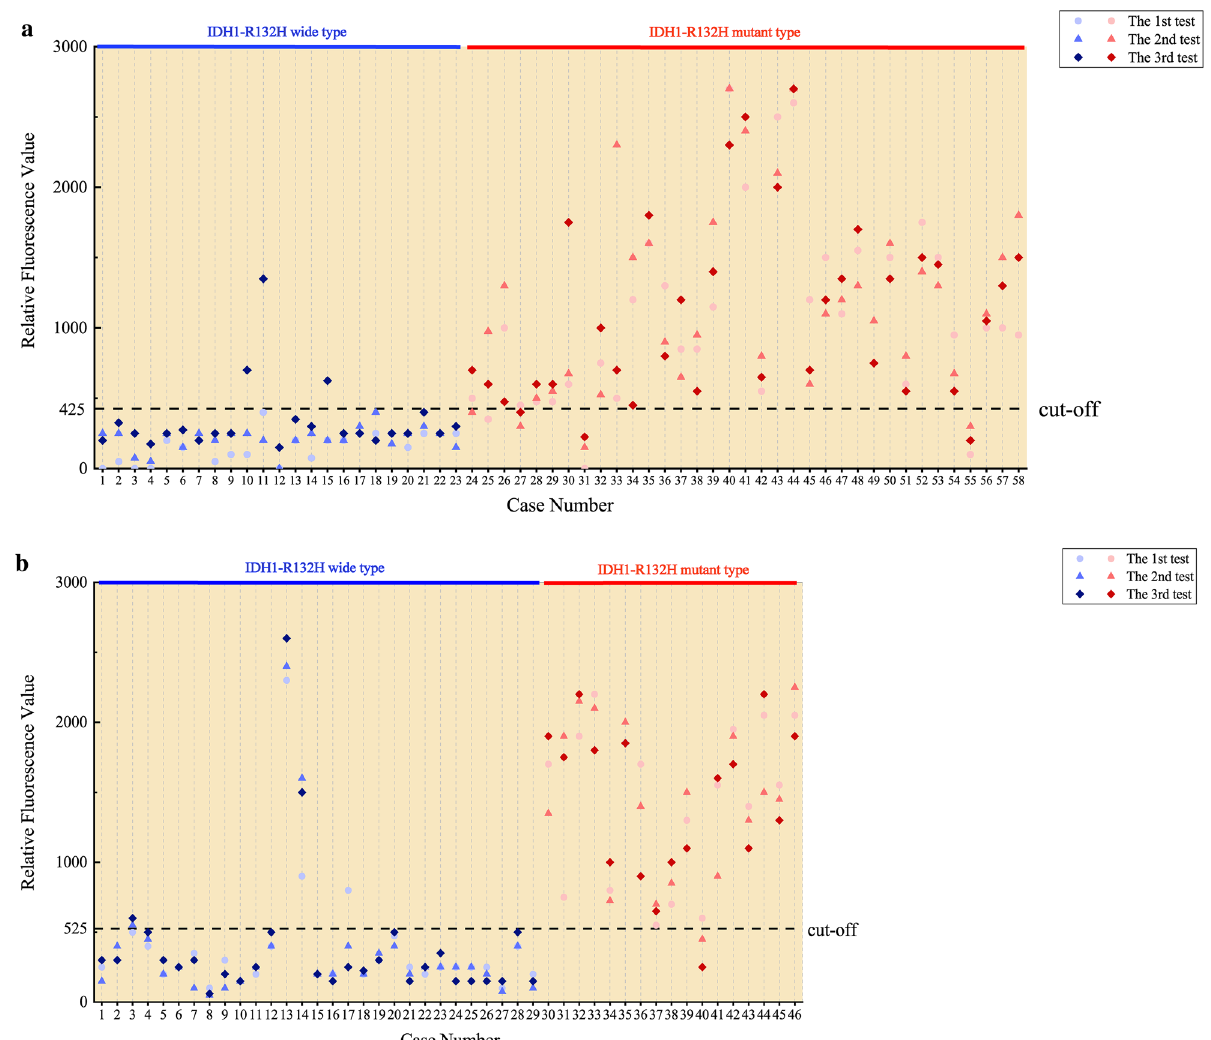
Figure 5. Scatter diagram of relative fluorescent value. ( a ) The relative fluorescent value of all samples in Group 1. No.10, No.11 and No.15 IDH1-wt samples had high relative fluorescent value, while No.8 and No.32 IDH1-R132H samples had low relative fluorescent value, which was not consistent with the gold standard. ( b ) The relative fluorescent value of all samples in Group 2. There was a significant difference between the relative fluorescent value of IDH1-wt and IDH1-R132H. No.13 and No.14 IDH1-wt samples and No.12 IDH1-R132H samples present abnormal relative fluorescent value. Fortunately, such errors were limited and tolerable (link: https:// www. origi nlab. com/, version OriginPro 2018C).